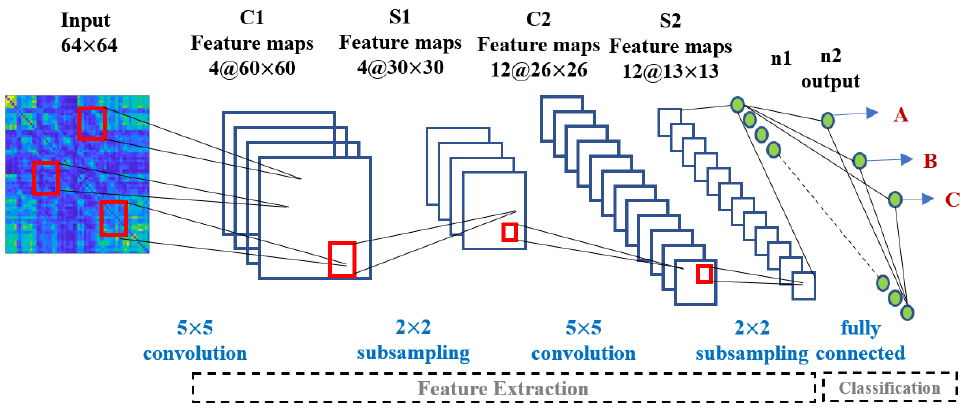
Figure 1. The detailed strcture of CNN as the input signal, mutual information-based weighted undirected correlation matrix about proposed paradigm.